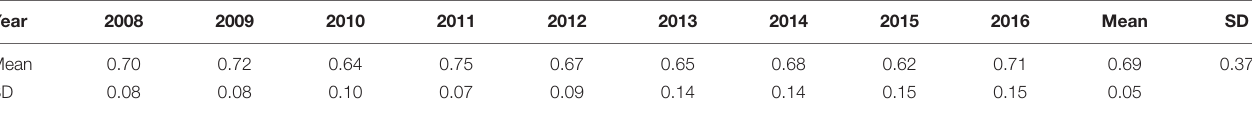
TABLE 4 | Summary of mean and standard deviation for the ratio of track counts to successful nesting for K5–K13 for 2008–2016.